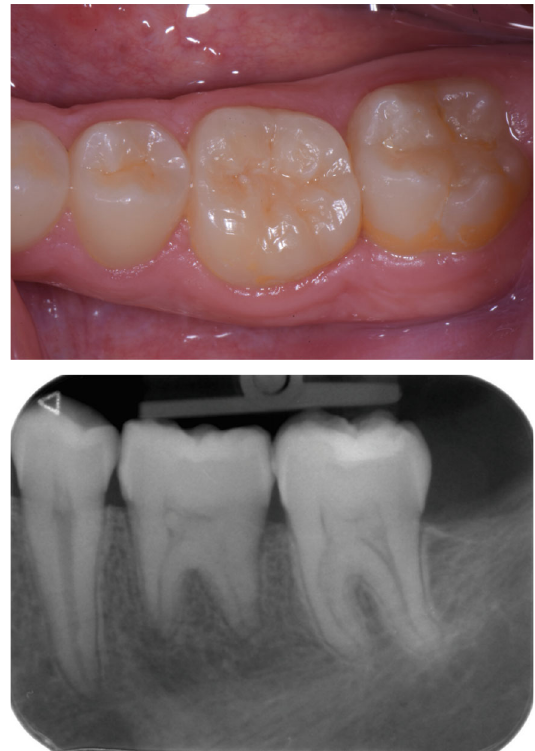
Figure 4: Tooth 36 at 1 year of follow-up.